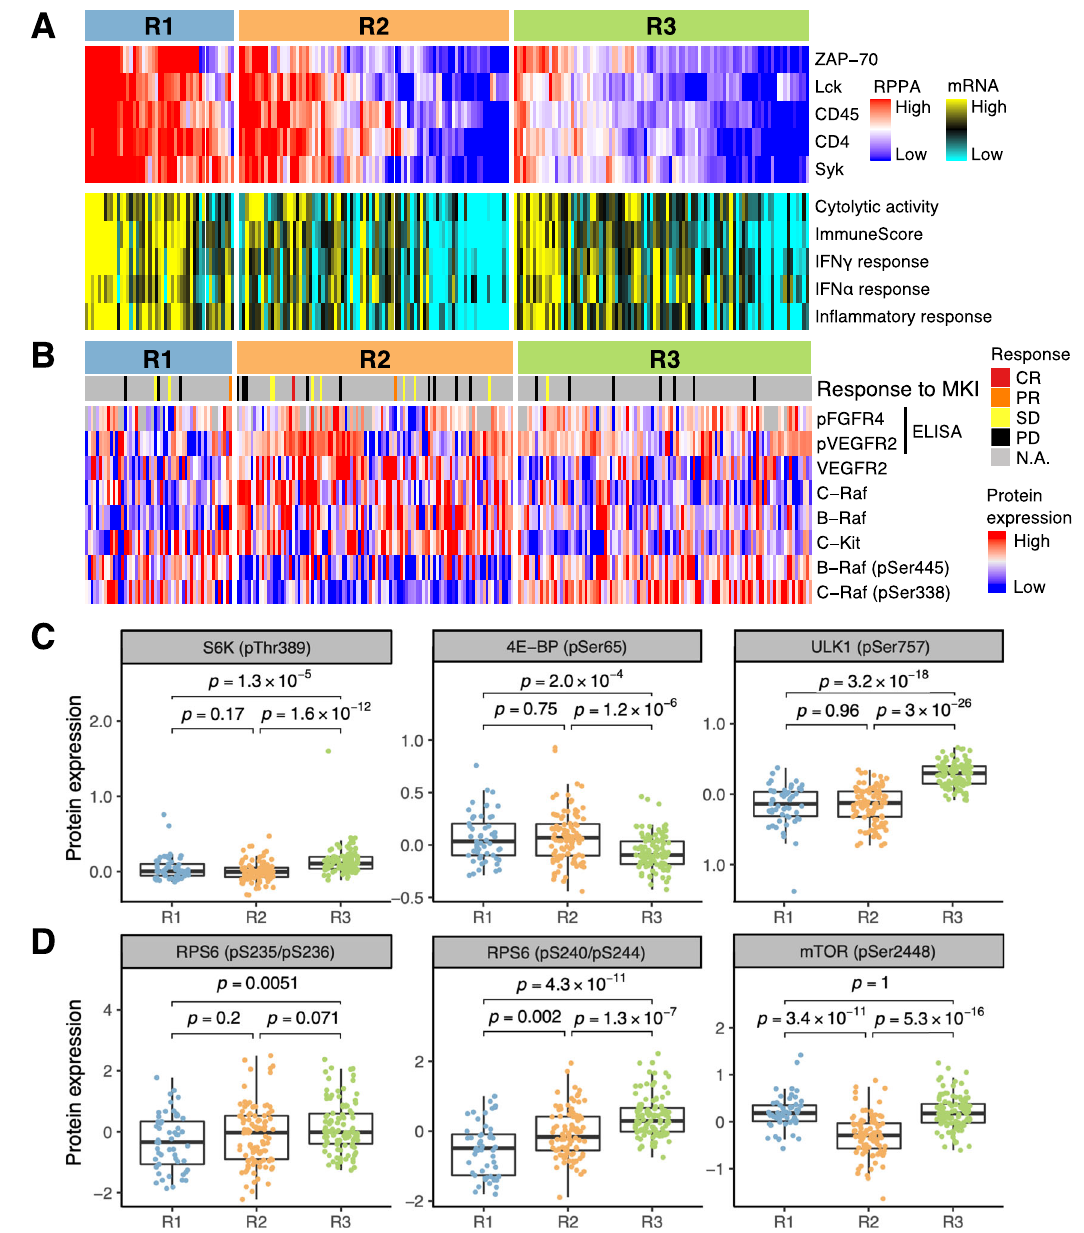
Fig. 5 | Therapeutic implications of the proteomic subclasses. A Immunity- relatedgeneexpressionsignaturesintheproteomicsubclasses.Proteinexpression levels of lymphocyte-associated genes (top) and mRNA signatures for immunolo- gical activity (bottom) are shown. B Expression levels of VEGFR2 and target pro- teinsofMKIs.ExpressionlevelsweremeasuredusingELISA(pFGFR4andpVEGFR2) or RPPA (other six proteins). Therapeutic response of 32 patients to MKI (31 to sorafenib, 1 to lenvatinib) are also shown. CR complete response, PR partial response,SDstabledisease, PDprogressivedisease. C , D Phosphorylationlevelsof